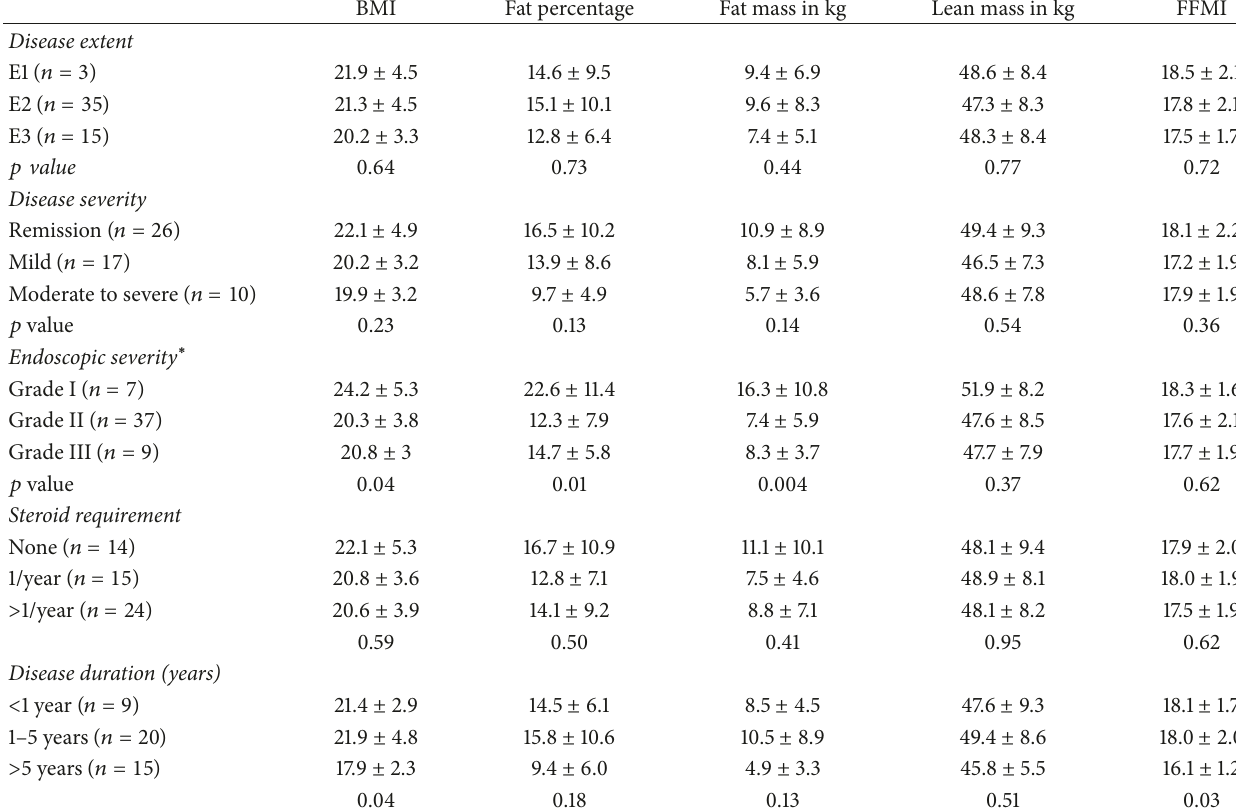
Table 3: Effect of disease extent, clinical and endoscopic severity, steroid requirement, and disease duration on body fat and lean mass in patients with ulcerative colitis. BMI Fat percentage Fat mass in kg Lean mass in kg